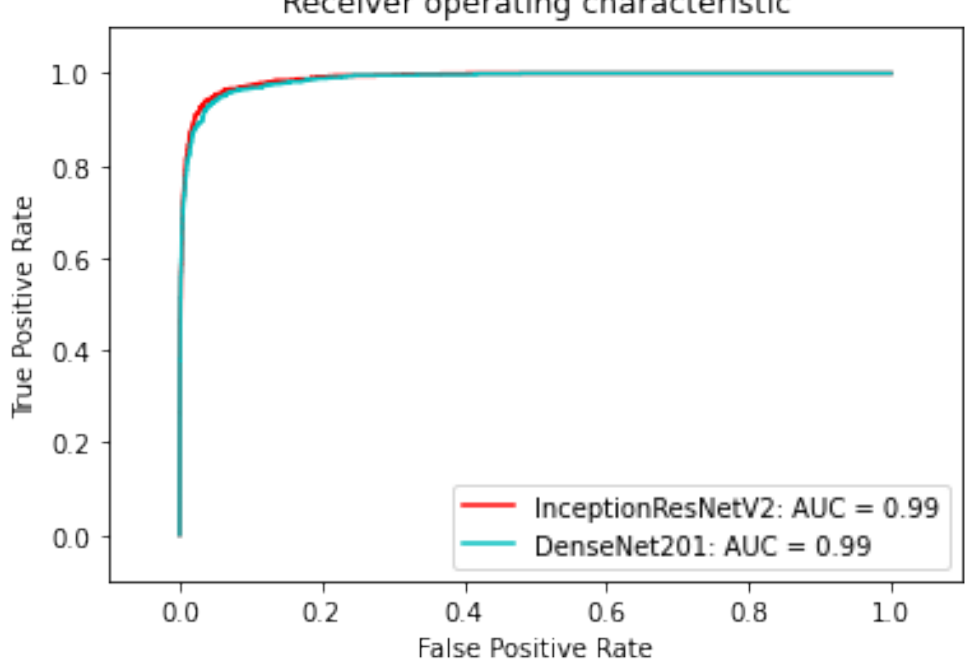
Figure 16. ROC of DenseNet201 and InceptionResNetV2.